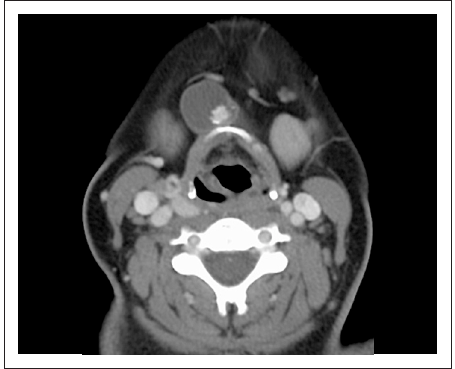
FIGURE 2: Axial computerised tomography (CT) scan image of the neck at the level of the hyoid bone, demonstrating the thyroglossal duct cyst (TDC) with a partly calcified, papillary, intracystic nodule.